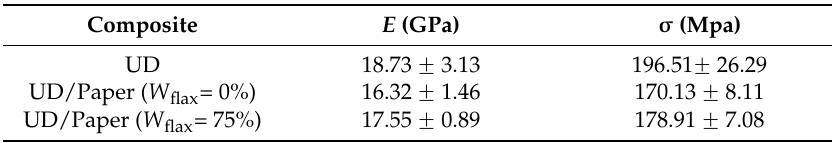
Table 7. Comparison of tensile properties, V f = 35%.